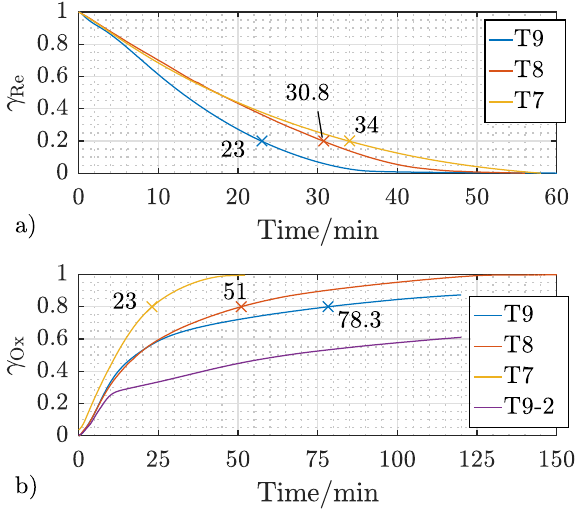
Figure 8. Effect of the reaction temperature on the temporal reduction ( a ) and oxidation ( b ) fractions of S1 at a reactant flow rate of 250mL/min and the gas concentration ro 4 as defined in Table 2; T7 = reaction temperature 700°C, T8 = reaction temperature 800°C, T9 = reaction temperature 900°C, Cycle 1, T9-2 = reaction temperature 900°C, Cycle